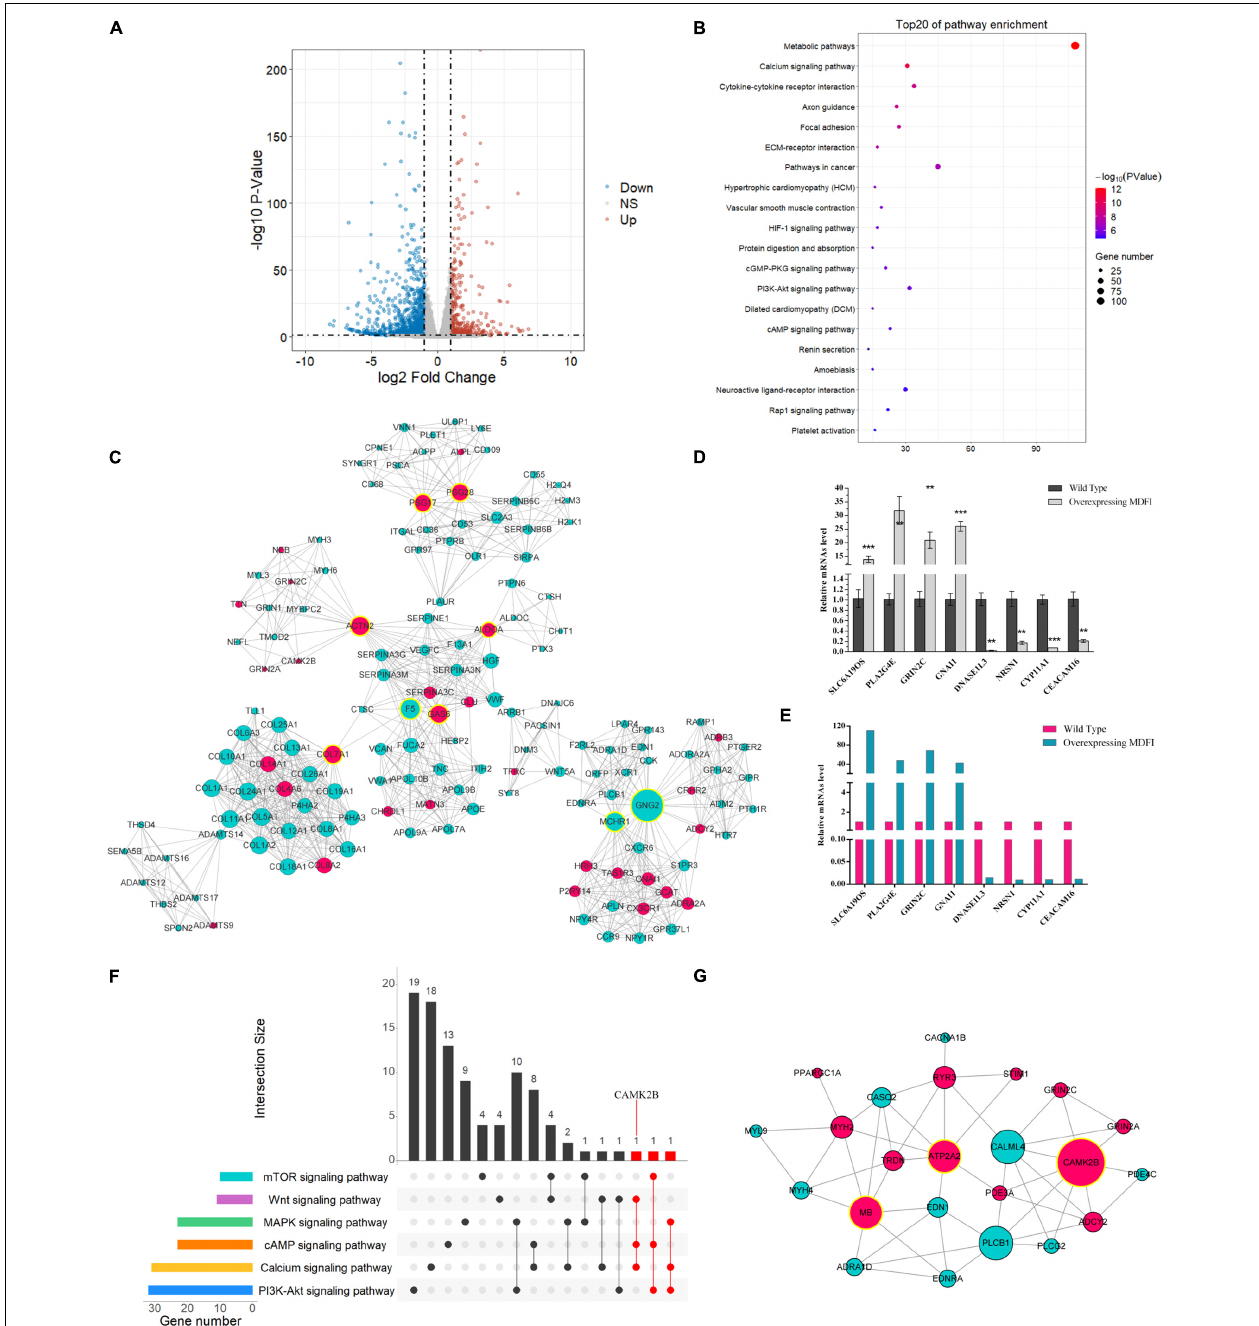
FIGURE 4 | RNA-seq analysis in Mdfi-OE vs. WT C2C12 cells. (A) The Volcano plot displays an overview of the DEGs. The X-axis represents the log-transformed P -value, and the Y-axis indicates the multiple of the DEGs. The gray dots represent DEGs that are not differentially expressed, the red dots represent the upregulated DEGs, and the blue dots represent the downregulated DEGs. |Log2FoldChange| > 1 and p < 0.05 were set as the criteria. (B) The first twenty pathways of the DEGs. The X-axis represents the number of DEGs enriched in the pathway. (C) PPI network in Mdfi-OE vs. WT. The network displays gene interactions. Nodes represent genes, and edges represent gene interactions. The upregulated genes are shown in red, downregulated genes are shown in green, and hub genes are shown in yellow. (D) qPCR validated of DEGs. (E) Expression levels of DEGs in RNA-seq. ** p < 0.01, *** p < 0.001. (F) The upset plot of the intersection of each pathway. The transverse bar graph at the bottom left shows the number of genes enriched in each pathway. The black points in the dot matrix at the bottom left and in the bar graph at the top indicate genes included in the pathways. The bars above represent the number of genes corresponding to each intersection. The red bars represent the number of intersection genes enriched in three or more pathways ( n ≥ 3). (G) The gene network displayed the gene interactions and was generated by Cytoscape (version 3.6). Nodes represent genes, and edges represent gene interactions. The upregulated genes are shown in red, downregulated genes are shown in green, and hub genes are shown in